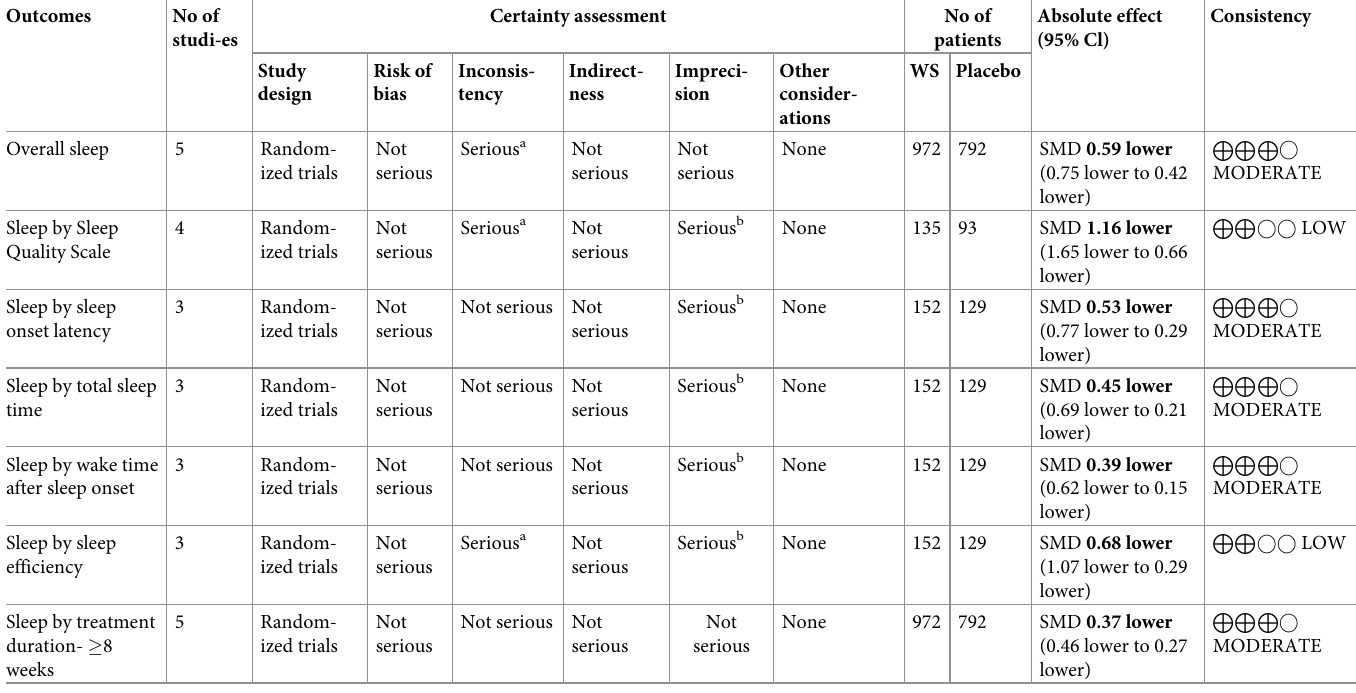
Table 2. Summary of findings by GRADE quality assessment.